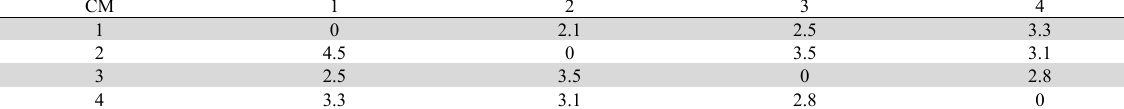
Trading costs between CMs (USD/MW). CM model and INT models